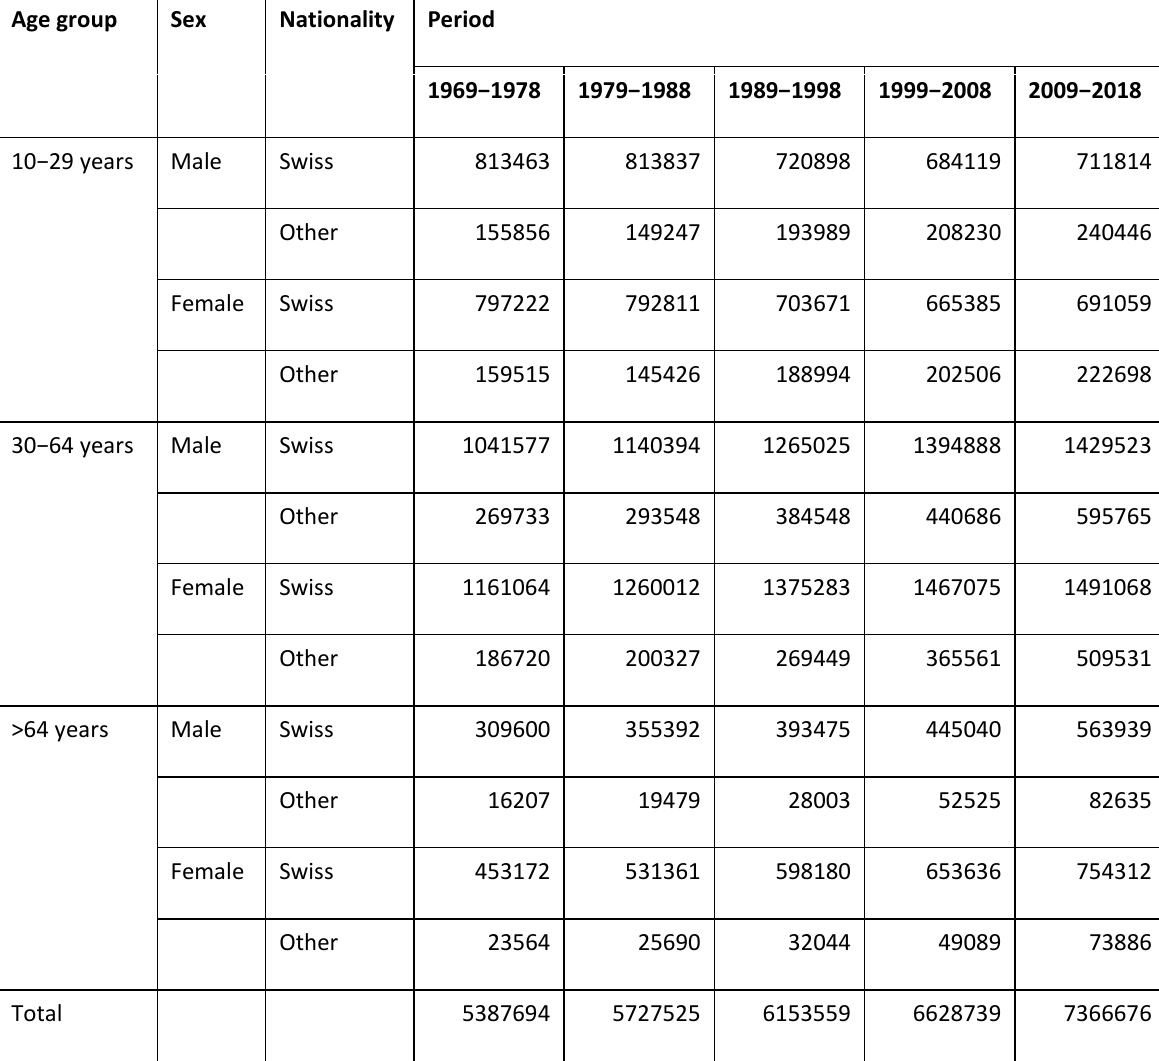
Table S1. Resident population (annual mean) in Switzerland